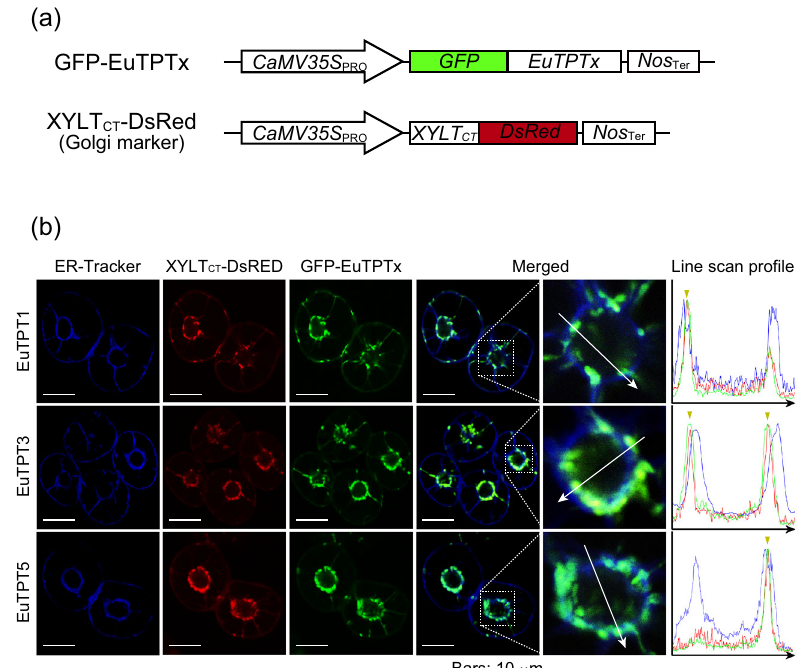
Fig. 2 Subcellular localization analysis of EuTPTx. a Schematic representation of chimeric construct GFP-EuTPTx. The coding regions of EuTPTx were fused to the C-terminus of GFP . XYLT CT -DsRed was used as Golgi marker. CaMV35S PRO , cauli fl ower mosaic virus 35S promoter; Nos Ter nopaline synthase terminator. b Triple-color imaging by confocal laser scanning microscopy of GFP-EuTPTx-expressing BY-2 cells. Top panels, EuTPT1; middle panels, EuTPT3; bottom panels, EuTPT5. Panels from left to right: ER marker (ER-Tracker), Golgi marker (XYLT CT -DsRed), GFP-EuTPTx, and merged images of these three fl uorescence signals. (Right) Magni fi ed images of boxed areas around the Golgi/ER/nucleus area are shown. A fl uorescence intensity line scan pro fi le was generated along the white arrow in enlarged view, which goes across the Golgi/ER/nucleus area and is shown in the right column. Yellow triangles indicate merged signals of XYLT CT -DsRed and GFP-EuTPTx. Blue, ER-Traker; red, XYLT CT -DsRed; green, GFP-EuTPTx. White scale bars: 10 μ